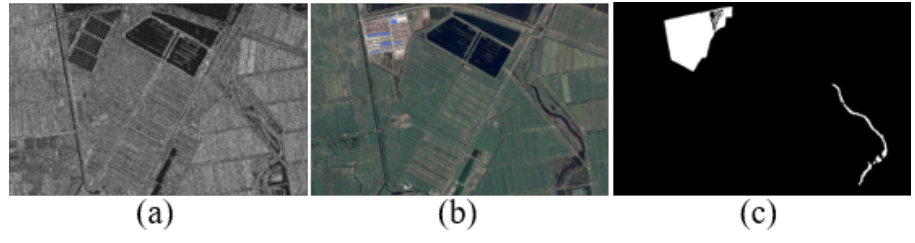
Figure 5. Shuguang dataset. ( a ) Radarsat-2 SAR image. ( b ) Google Earth optical image. ( c ) Ground-